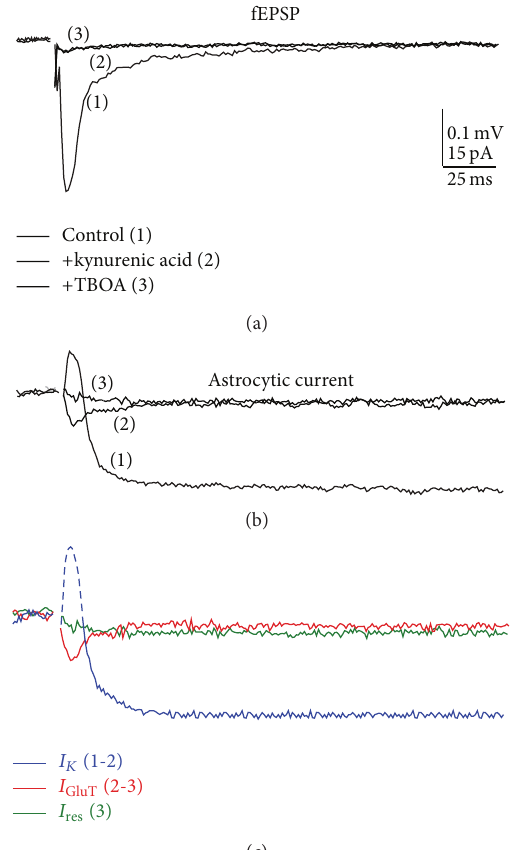
Figure 1: Pharmacological isolation of astroglial currents. Dual patch clamp recordings revealed synaptically evoked astroglial currents in hippocampal CA1 region. Sample traces are shown for simultaneously recorded (a) neuronal field excitatory postsynaptic potentials (fEPSPs) and (b) astroglial currents induced by a single stimulation of Schaffer collaterals. This was carried out under control conditions (100 𝜇 M picrotoxin; 1), and subsequent addition of an ionotropic glutamate receptor antagonist (5mM kynurenic acid; 2), and a glutamate transporter antagonist (200 𝜇 M TBOA; 3). (c) Sample traces of pharmacologically isolated astroglial currents are shown. Astrocytic potassium current was isolated by subtracting the kynurenic acid-insensitive component from the total current ( 𝐼 𝐾 , 1-2, blue). Note that the initial fast outward current component (dash blue) reflects fEPSPs generated by adjacent pyramidal cells, while 𝐼 𝐾 corresponds to the slow inward current (solid blue). The kynurenic acid insensitive current (2) consists of a fast inward current and a slow residual component of smaller amplitude; the latter was isolated by subsequent application of TBOA ( 𝐼 res , 3, green). Subtraction of 𝐼 res from the response in the presence of kynurenic acid resulted in the glutamate transporter current component ( 𝐼 GluT , 2-3, red). Scale bars = 0.1mV for fEPSPs, 15pA for astroglial currents; 25 ms. This figure (a–c) is extracted from